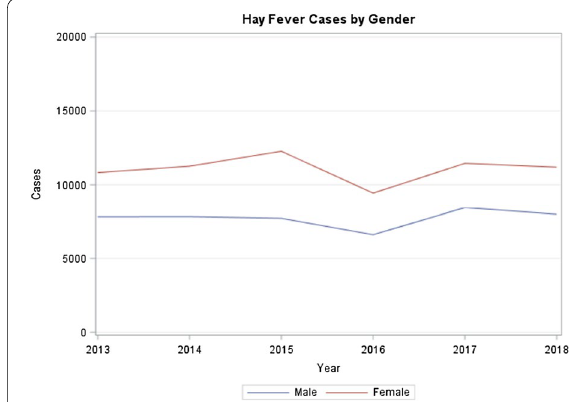
Fig. 1 Hay fever cases among adults by gender (frequency in thousands)